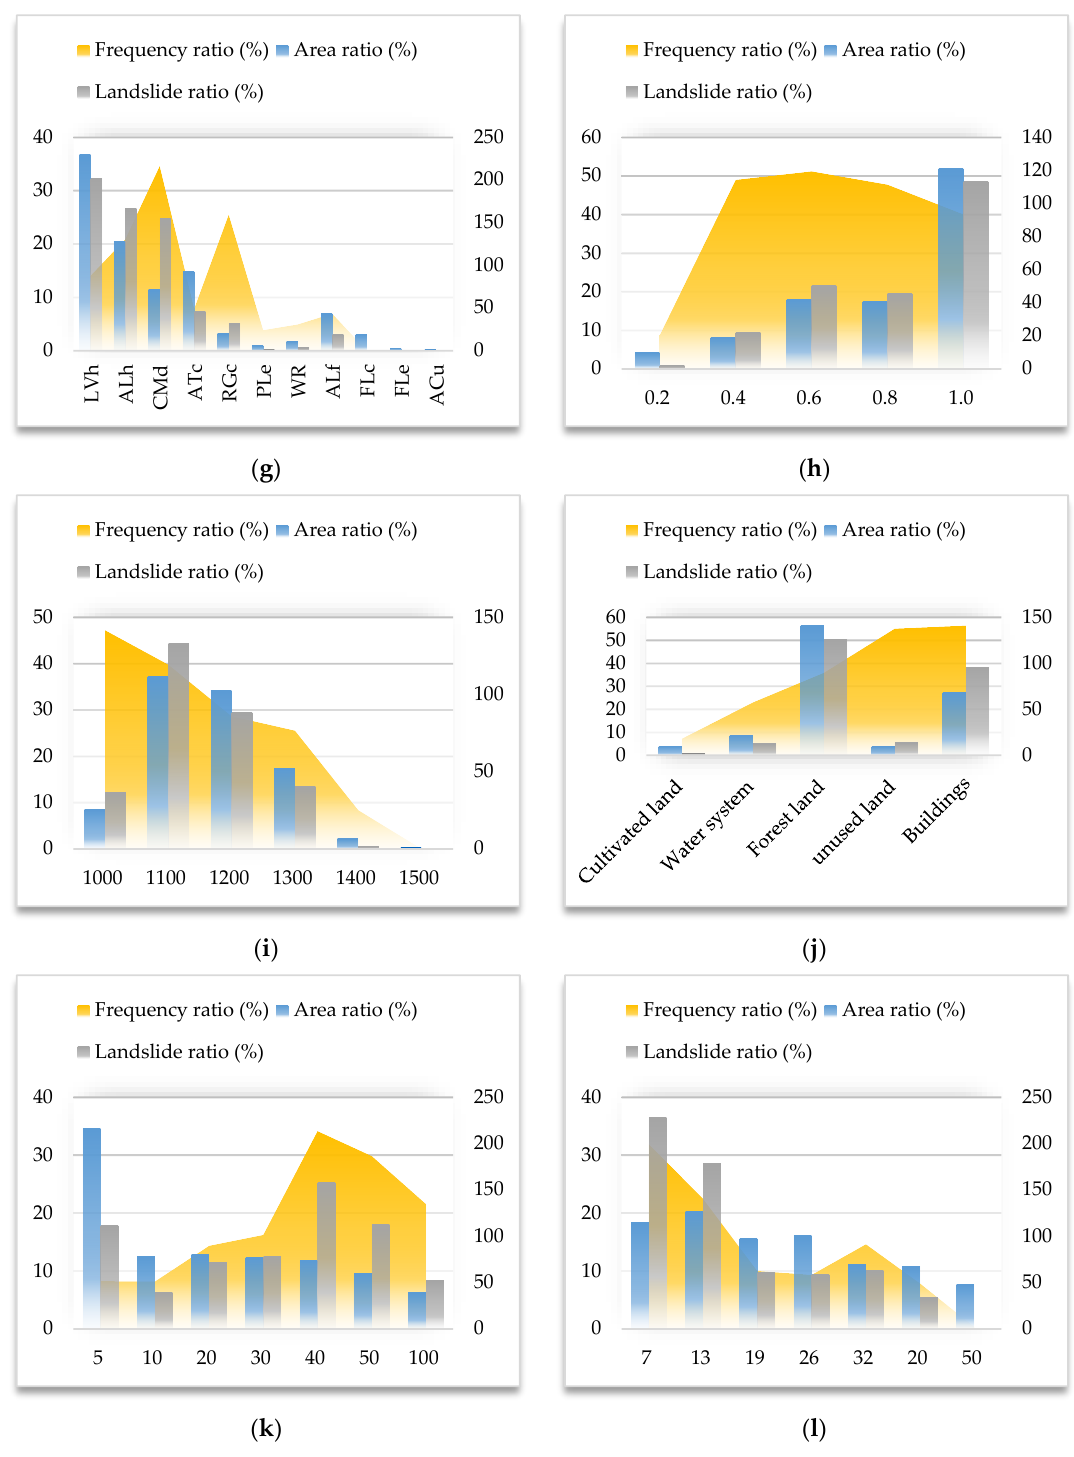
Figure 3. Analysis of influence factor and landslide frequency ratio. ( a ) Slope. ( b ) Aspect. ( c ) Landform. ( d ) Lithology. ( e ) Distance from fault. ( f ) Distance from water. ( g ) Domsoil. ( h ) NDVI. ( i ) Rainfall. ( j ) Landuse. ( k ) Distance from road. ( l ) Distance from mine. Where, the Landslides ratio is the gray histogram, indicating the proportion of landslides in each factor interval to all landslides; the Area ratio is the blue histogram, indicating the proportion of the area of each factor interval to the total area; the Frequency ratio is the yellow line graph, indicating the ratio of landslide proportion to area proportion in each factor